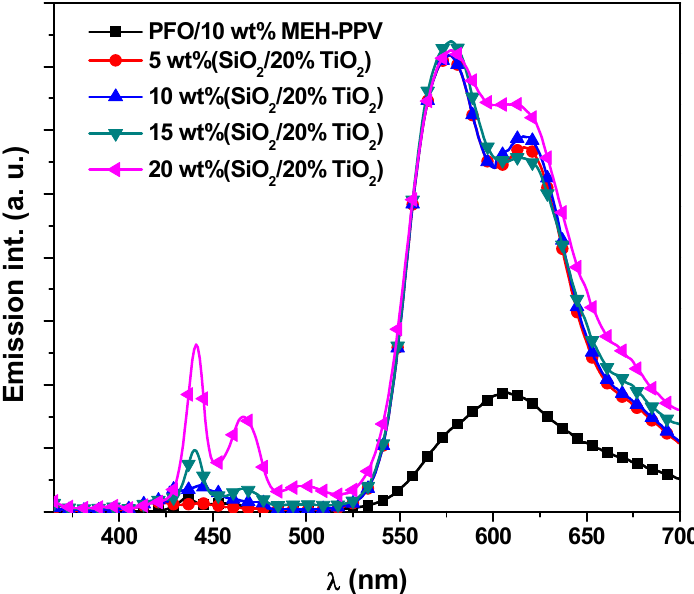
Figure 3. Emission spectra of PFO/MEH-PPV hybrid thin films with various ratios of STNCs.